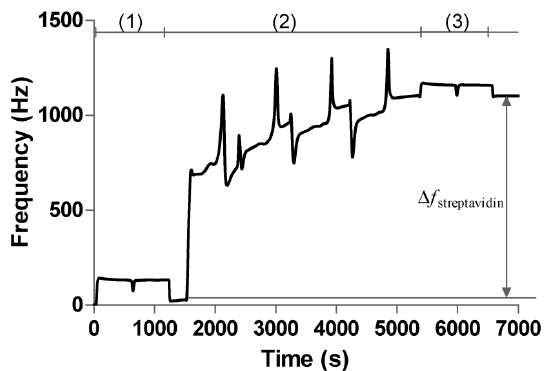
Figure 7. Procedure for immobilizing streptavidin via amine coupling on 3D carboxymethyl dextran (2000 kDa) surface; (1) activation by EDC and NHS; (2) coupling of streptavidin; (3) deactivation with ethanolamine.